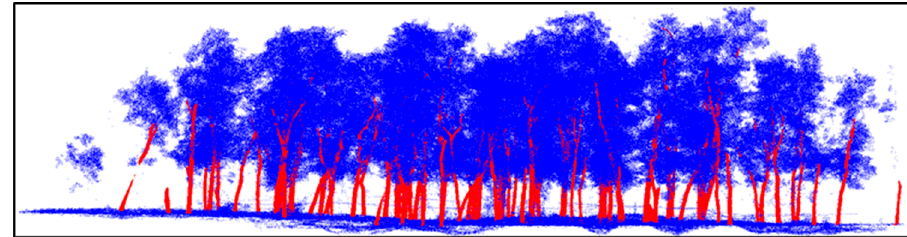
Figure 1. Illustration of the diverse stem forms of the plot 7. The stem points were displayed in red, and the non-stem points were displayed in blue.